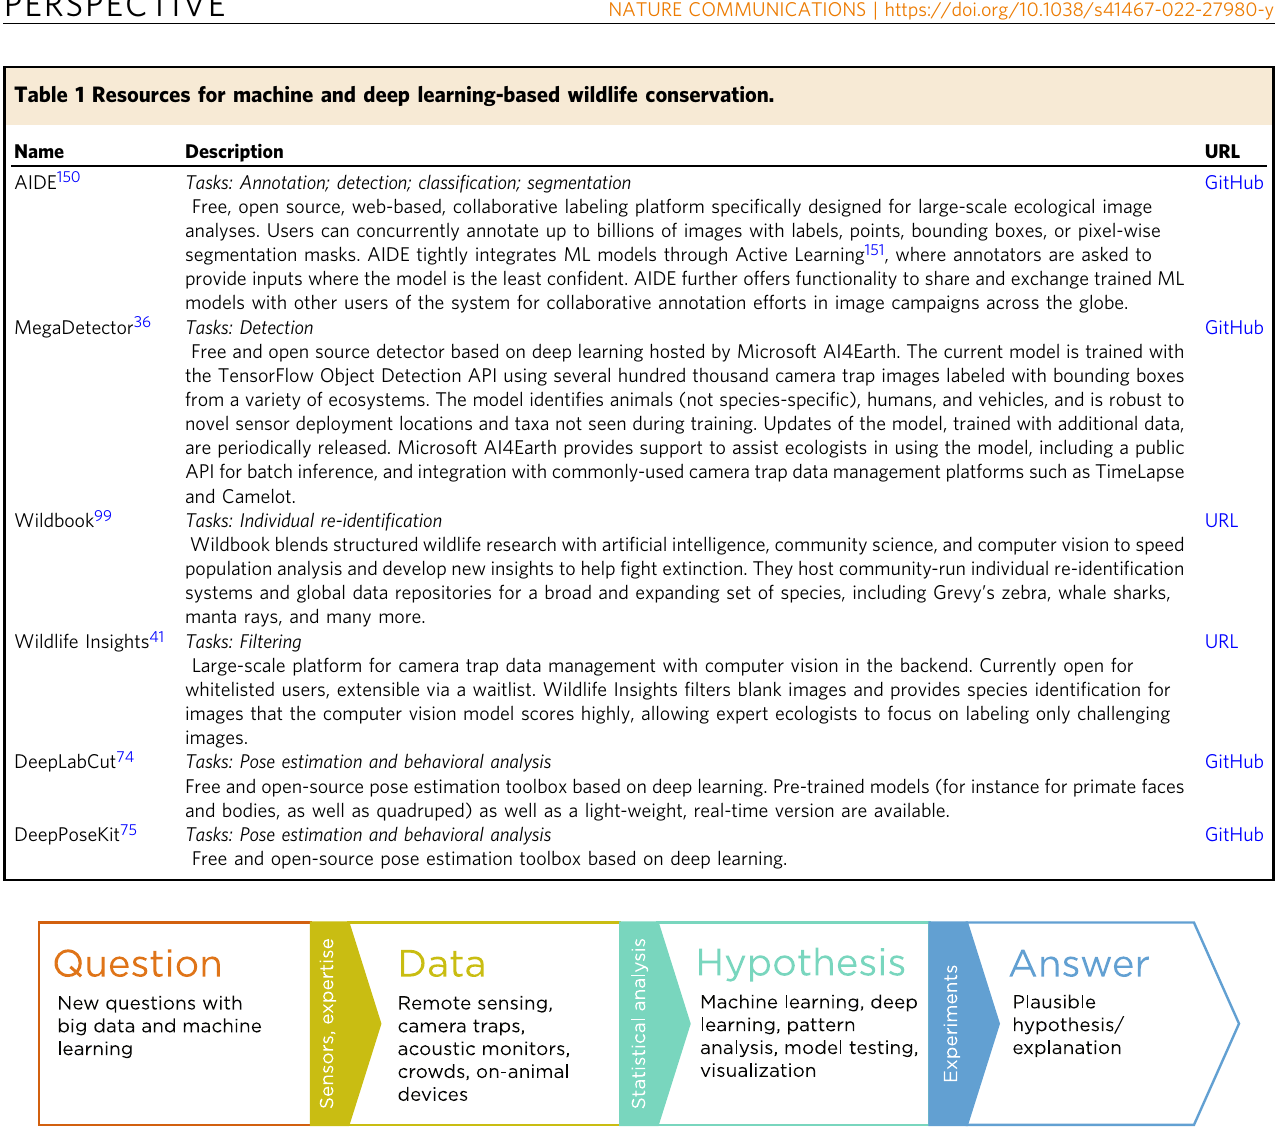
Fig. 2 Incorporating ML into the ecological scienti fi c process. Traditional ecological research pipeline (colored text and boxes) and contributions of ML to the different stages discussed in this paper (black